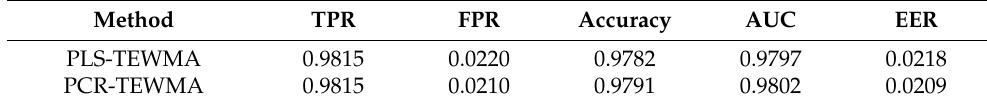
Figure 15. Detection results of ( a ) PLS- and ( b ) PCR-based TEWMA charts in the presence of RCCB faults. Table 5. Results of PLS- and PCR-based TEWMA charts under RCCB faults.